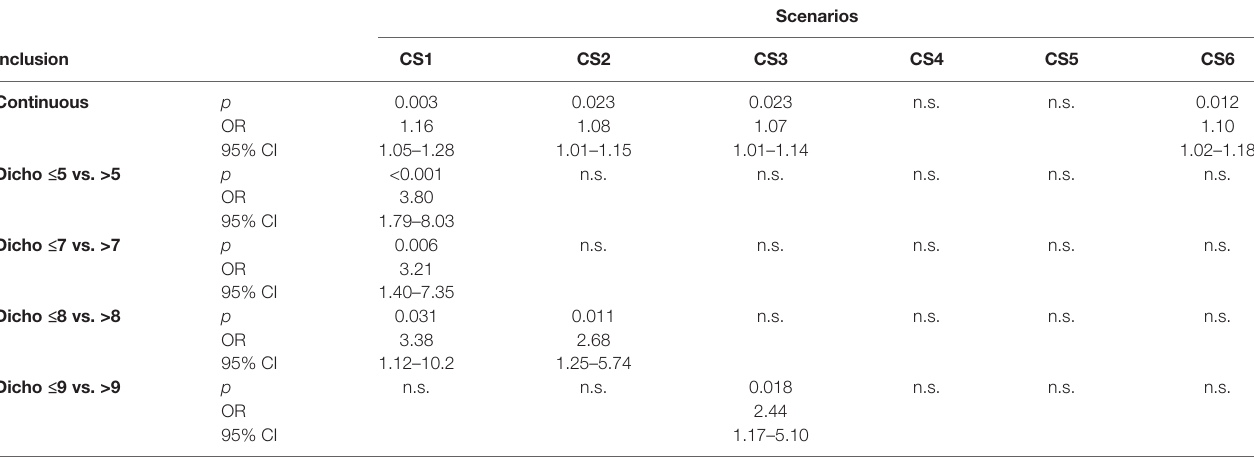
TABLE 2 | Multivariate relationship between number of cases and guideline-adherent treatment